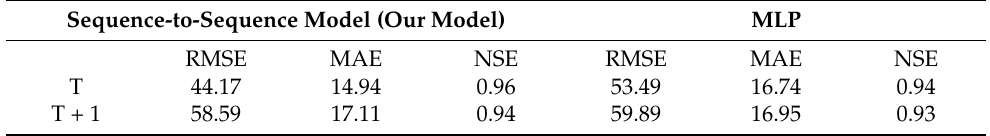
Table 11. Prediction accuracy results of our proposed model and the